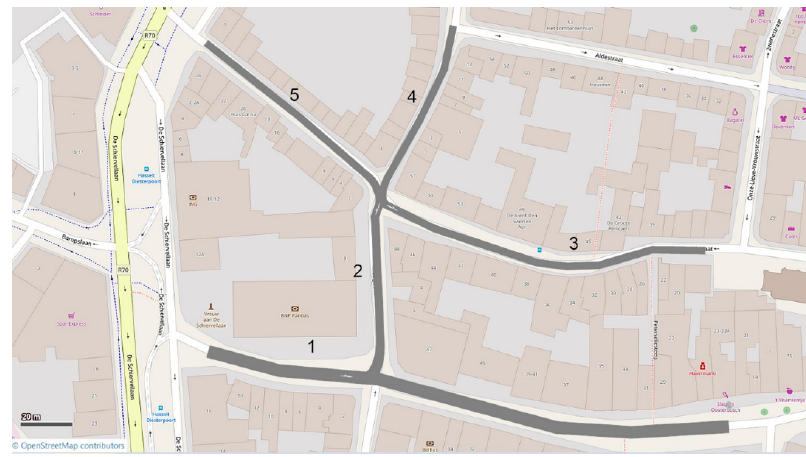
Figure 1. Road Network in PTV Vissim.